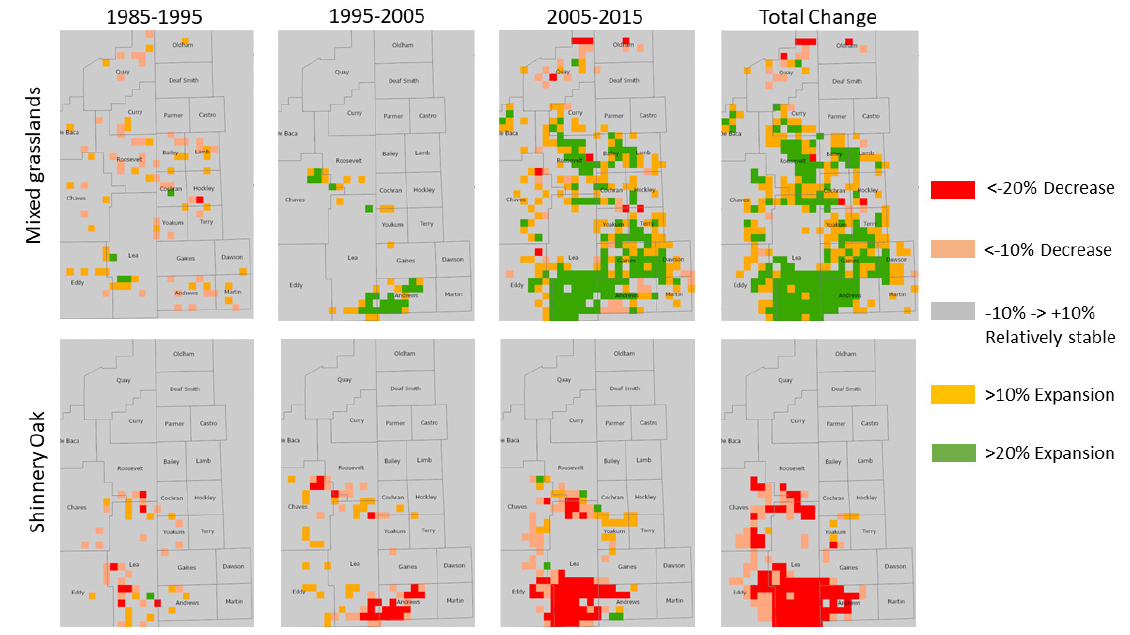
Figure 8. Spatial patterns in changes in extent from 1985 to 2015 for lesser prairie-chicken habitat in the Sand Shinnery Oak Ecoregion on the New Mexico and Texas Southern High Plains, as estimated from Landsat-based image classifications. Categories of negative and positive change in proportion were obtained by calculating the changes in land cover proportion in 10 km × 10 km cells from the time series of maps 1985, 1995, 2005, and 2015 using ArcGIS.